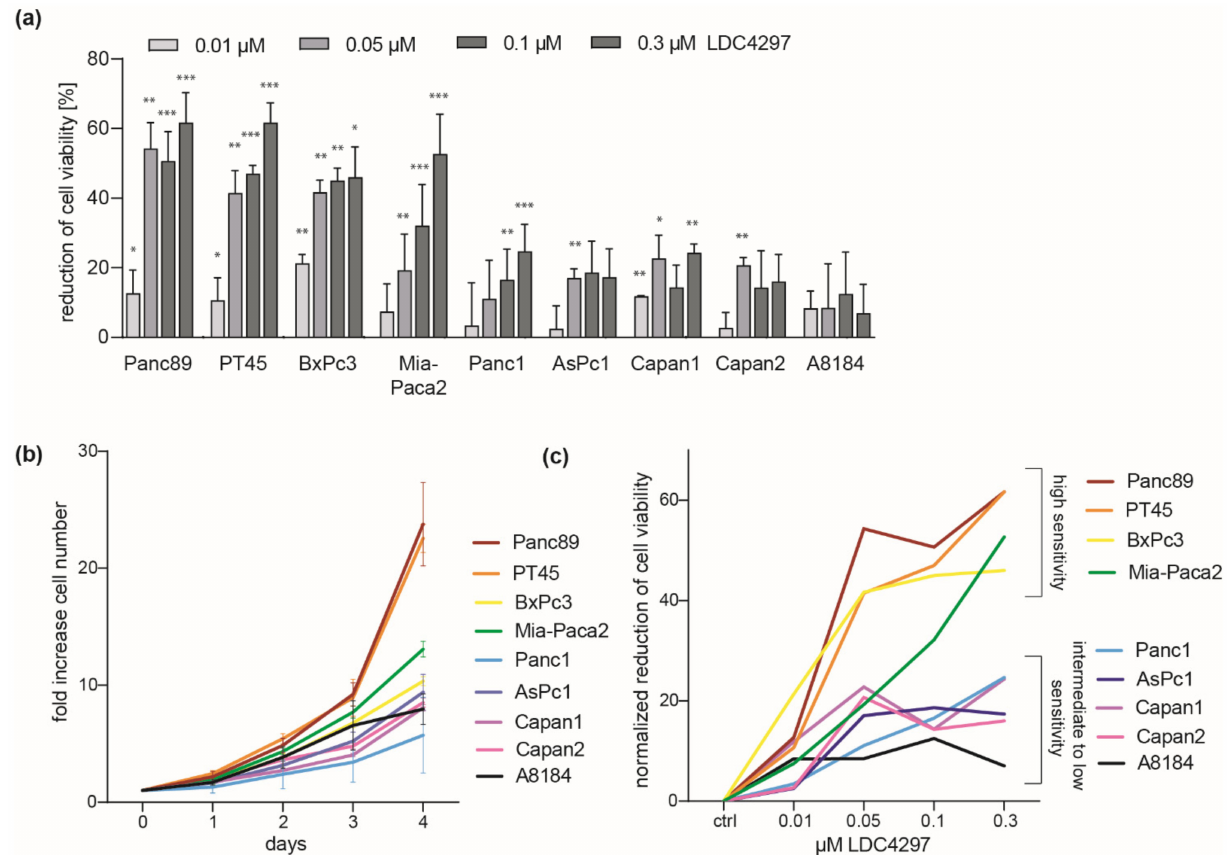
Figure 1. PDAC cells display cell line-specific sensitivity towards CDK7 inhibition. ( a ) Different PDAC cell lines were treated with the indicated doses of LDC4297 for 3 days and viability was